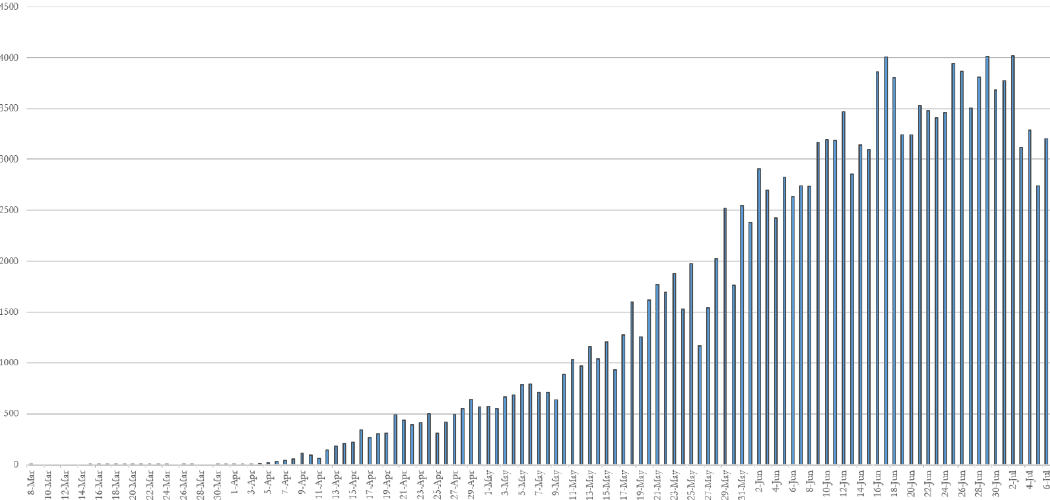
Figure 3. Confirmed COVID-19 cases up to 6 July 2020, (Source: Corona Virus Dashboard, Bangladesh). COVID: coronavirus disease.